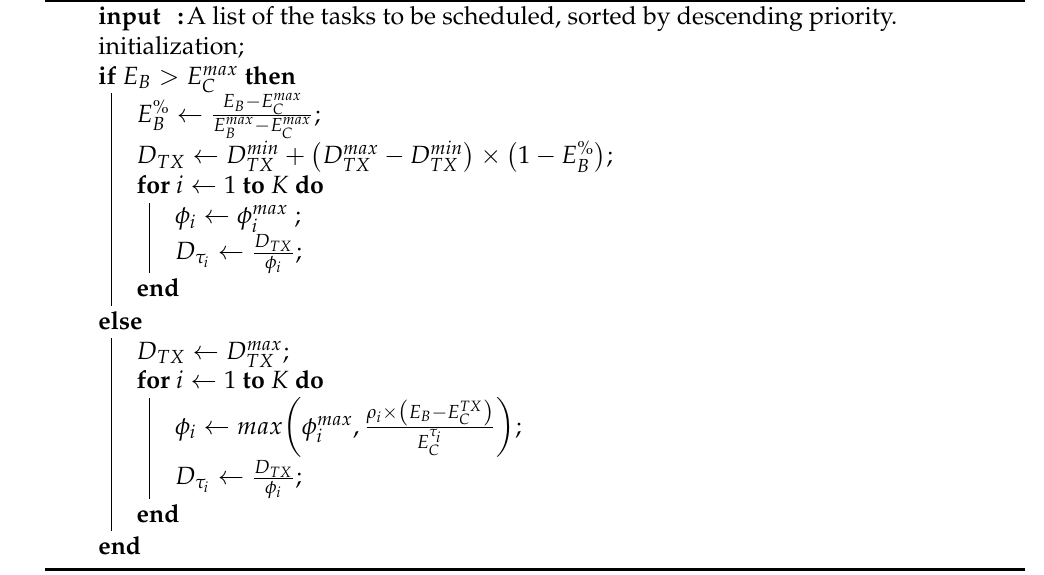
Algorithm 1: Optimal φ i calculation integrated in a practical solution